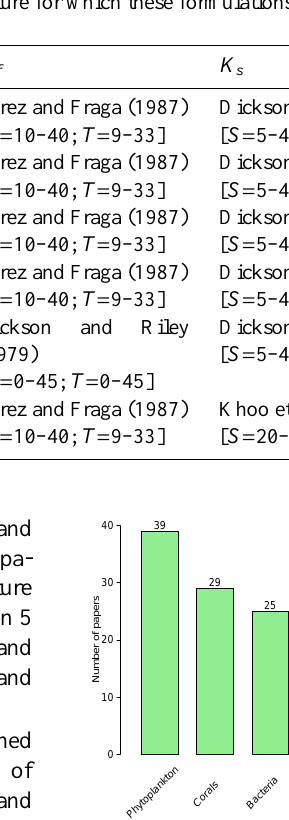
Table 3. Formulations used for the dissociation constants of carbonic acid ( K 1 and K 2 ), hydrogen fluoride ( K f ) and hydrogen sulfate ( K s ) in the 6 cases shown in Fig. 4. The ranges of salinity and temperature for which these formulations are valid are given in brackets.